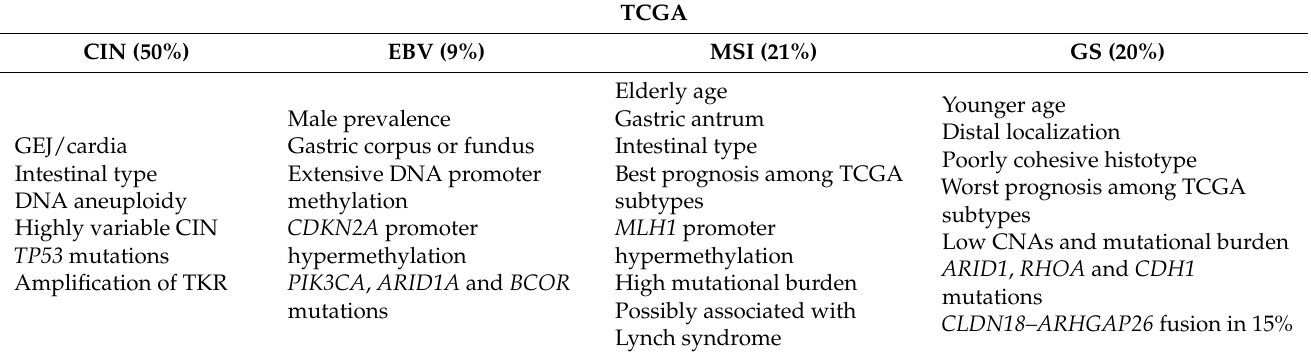
Table 1. Principal molecular and clinicopathological features of TCGA molecular subtypes.